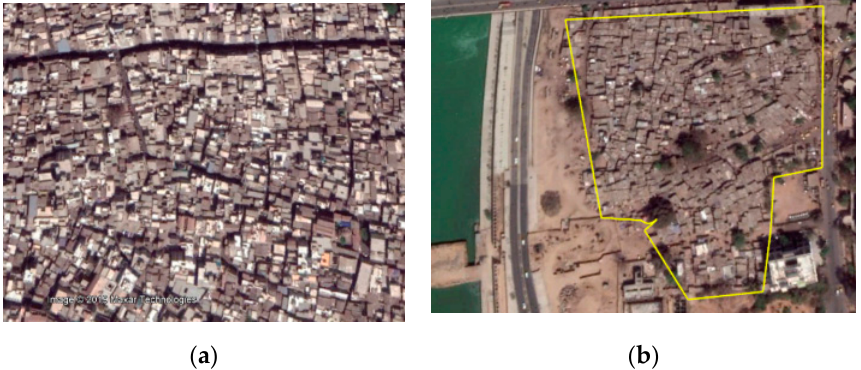
Figure 5. Ahmedabad, India: part of the historic city center ( a ) and deprived area ( b ) (source: Google Earth).